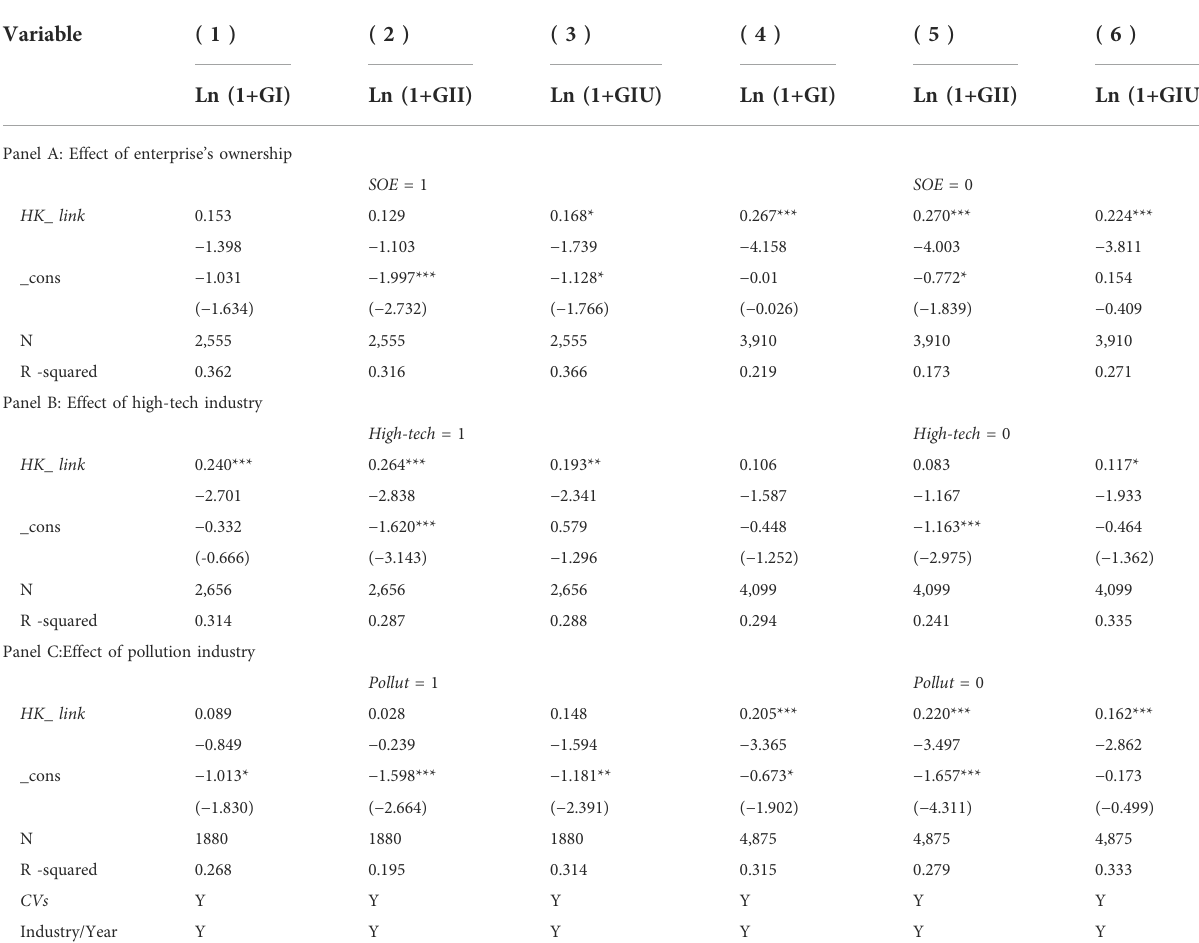
TABLE 10 Heterogeneous